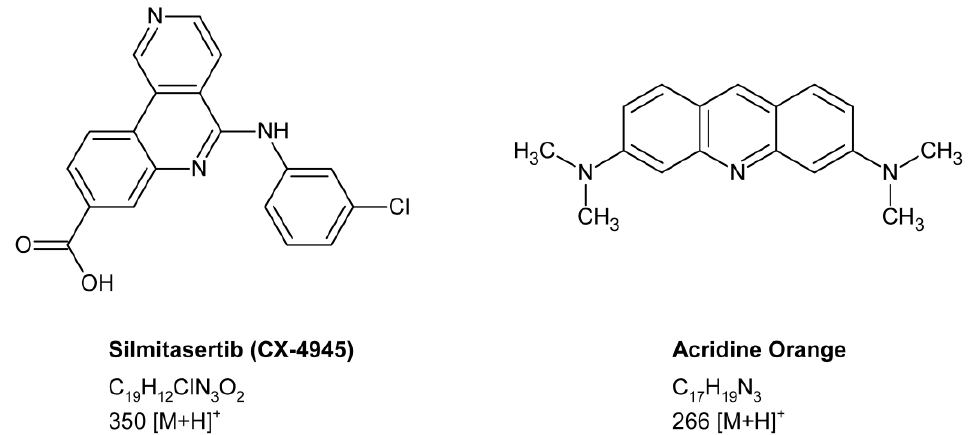
Figure 1. Chemical structures, molecular formulae, and precursor ions of the CK2 inhibitor silmitasertib (CX-4945) and the internal standard acridine orange.